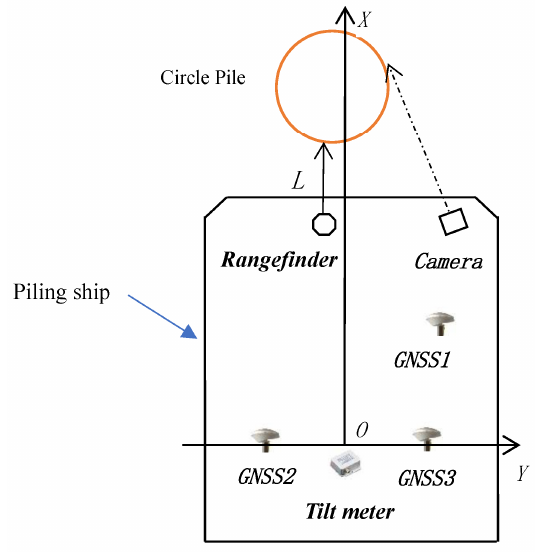
Figure 2. Pile positioning diagram.